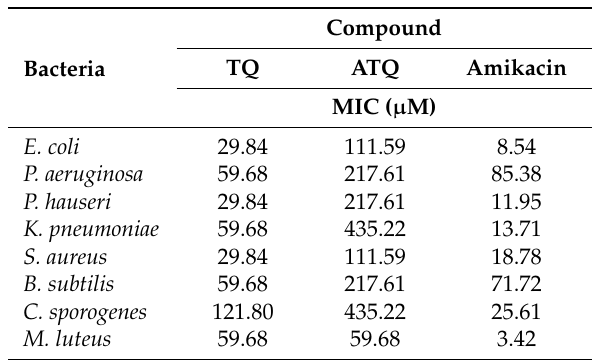
Table 2. In vitro antifungal activity presented as minimum inhibitory concentration (MIC/mM) values of investigated compounds.